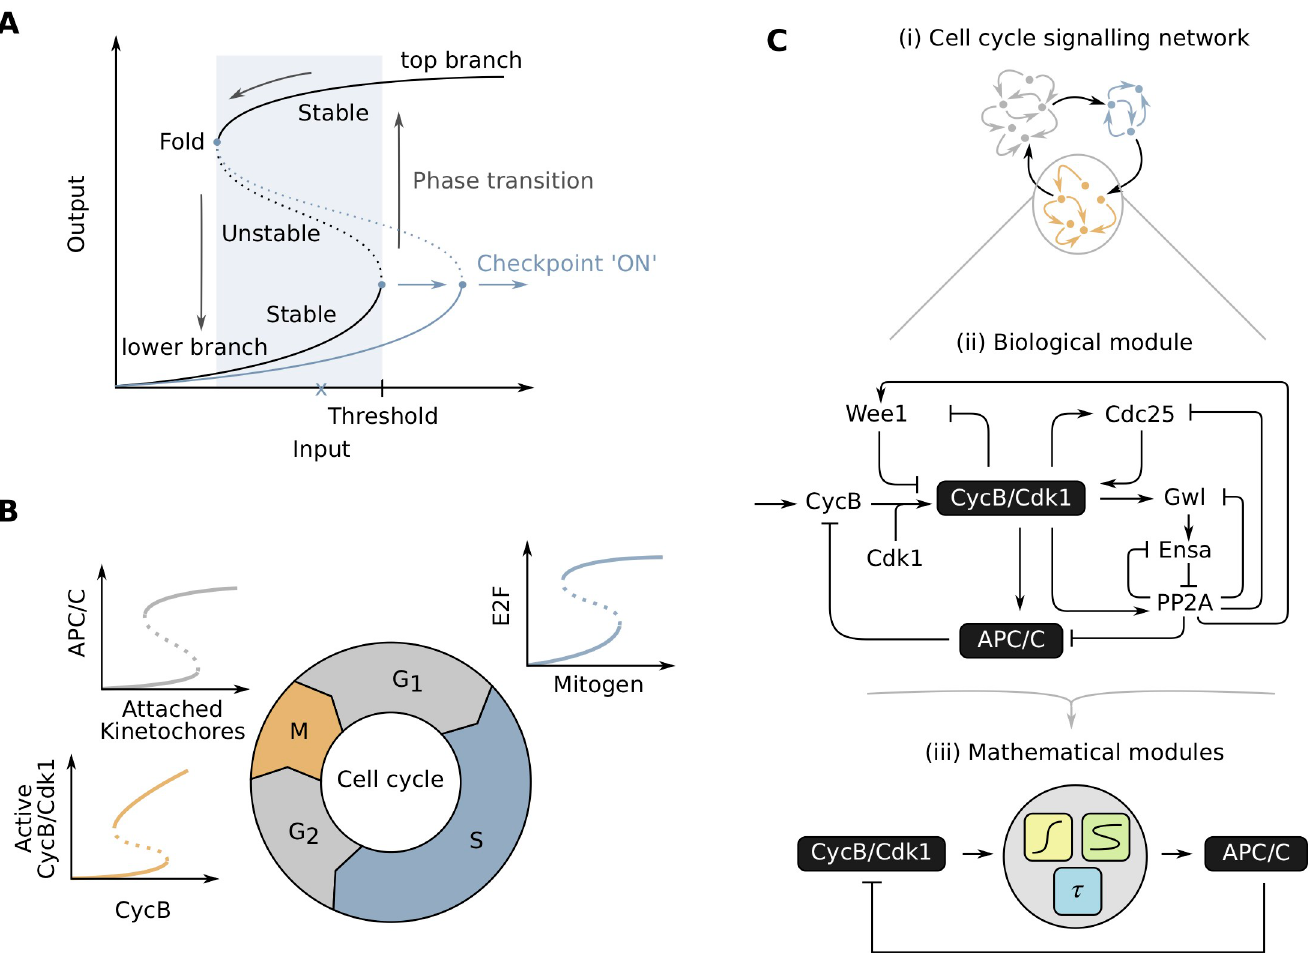
Fig 1. Modularity in the cell cycle. (A) An S-shaped response is characterized by the coexistence of two stable and one unstable steady states for a certain range of input levels (blue shaded area). Cell cycle transitions can be described as sudden jumps from the lower to upper branch of the curve (or vice versa). Checkpoints act by fixing the input at sub-threshold levels (x) or shifting the threshold value to a different input level (blue curve). (B) Different phase transitions in the cell cycle have been shown to be centered around bistable switches for which S-shaped response curves have been experimentally measured. (C) Entry into mitosis (and other cell cycle transitions) can be isolated as a biological module from the bigger network of other cell signaling events in the cell (i). Whereas the dynamical features of these modules have been studied extensively by considering detailed reaction schemes (ii), we propose a phenomenological approach based on three easily combinable ‘functional modules’: time delay, ultrasensitive and S-shaped responses